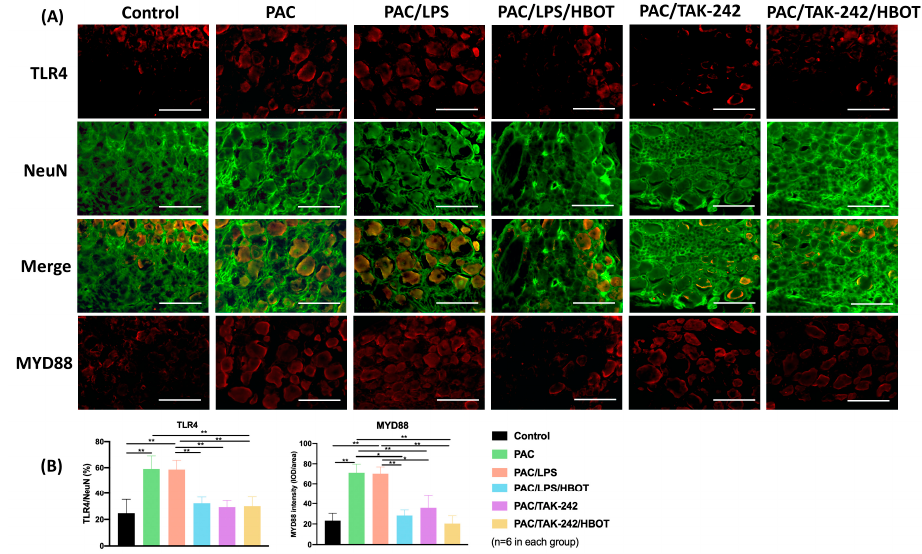
Figure 5. Expression of TLR4 and MyD88 in the rat DRG. ( A ) IF images indicating TLR4 and MyD88 antibody staining from the control, PAC, PAC/LPS, PAC/LPS/HBOT PAC/TAK-242, and PAC/TAK- 242/HBOT groups. IF staining of TLR4 (indicated by red) and DRG neurons (NeuN, indicated by green) was performed separately and then merged. Scale bar indicates 100 μ m. ( B ) Representative bar graphs illustrating the percentage of TLR4 and MyD88. Error bars, mean ± SEM ( n = 6 per group). * p < 0.05, ** p < 0.01 vs. control group. IF: immunofluorescence. DRG: dorsal root ganglion.